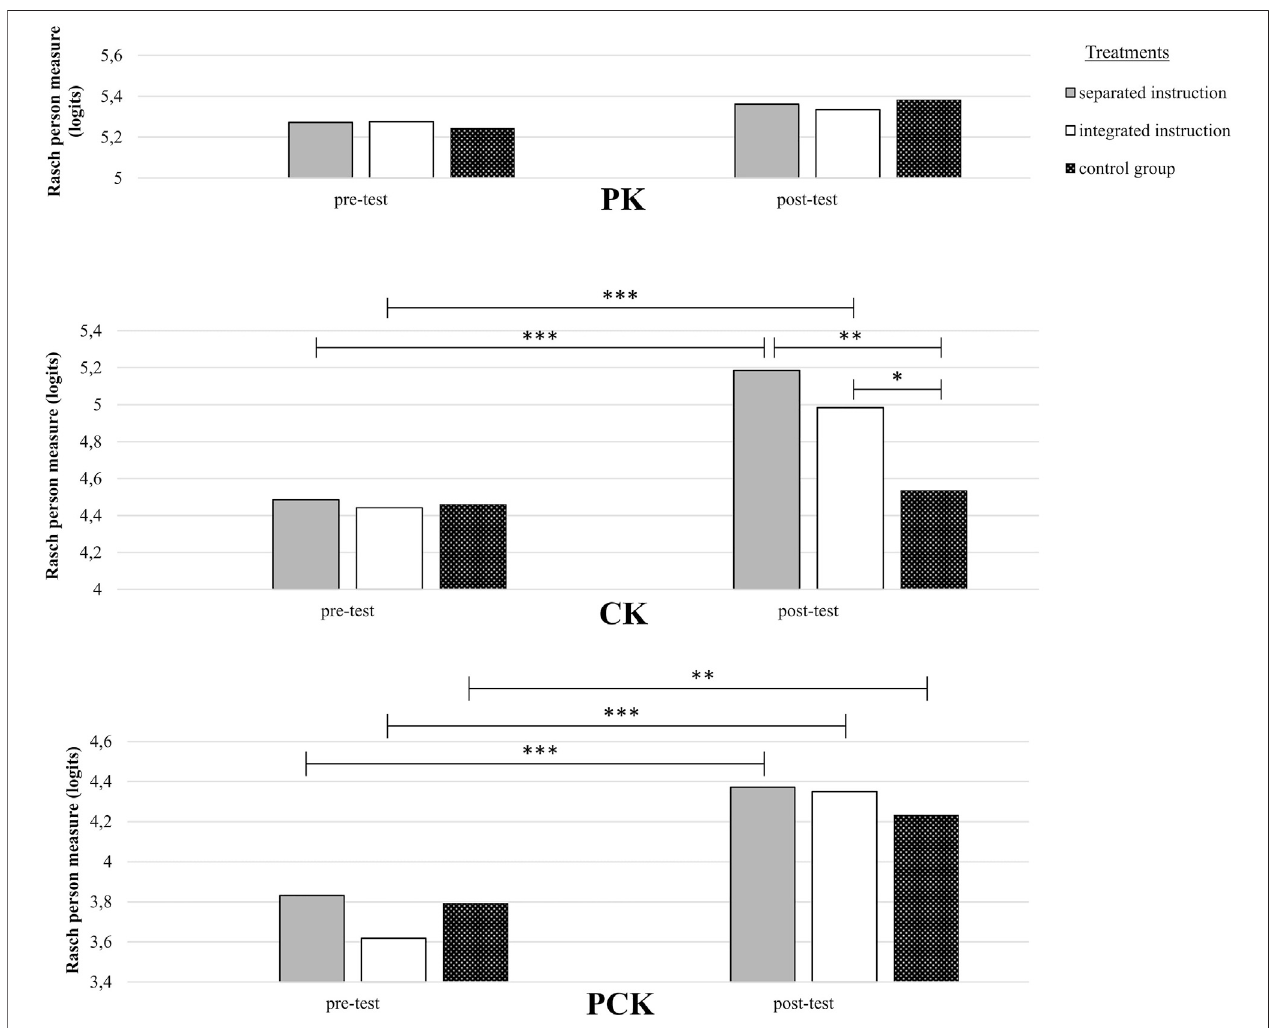
FIGURE 2 | Comparison of pre- and post-test person measures between the different treatments, illustrated for each knowledge facet (*** p < 0.001, ** p < 0.01, * p < 0.05). For PK and CK, mixed ANOVAs have been performed, whereas we run repeated ANOVAs for PCK. Note that the person measures were calibrated for each knowledge facet separately, and therefore, they cannot be compared with each